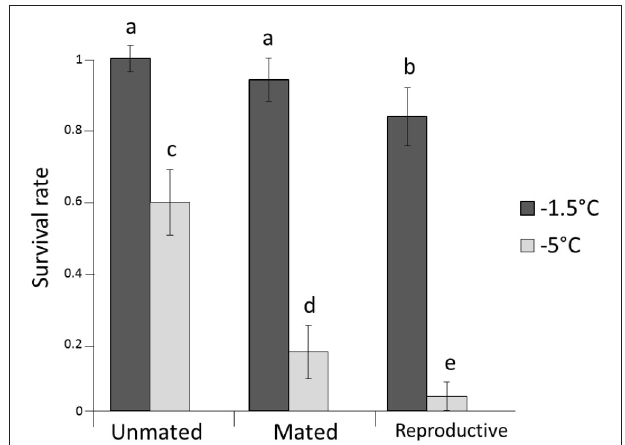
FIGURE 1 | Survival rates for females after exposed to − 1.5 and − 5 ◦ C. Error bars represent the 95% confidence interval around estimates of the mean. Lower case letters represent significant differences.